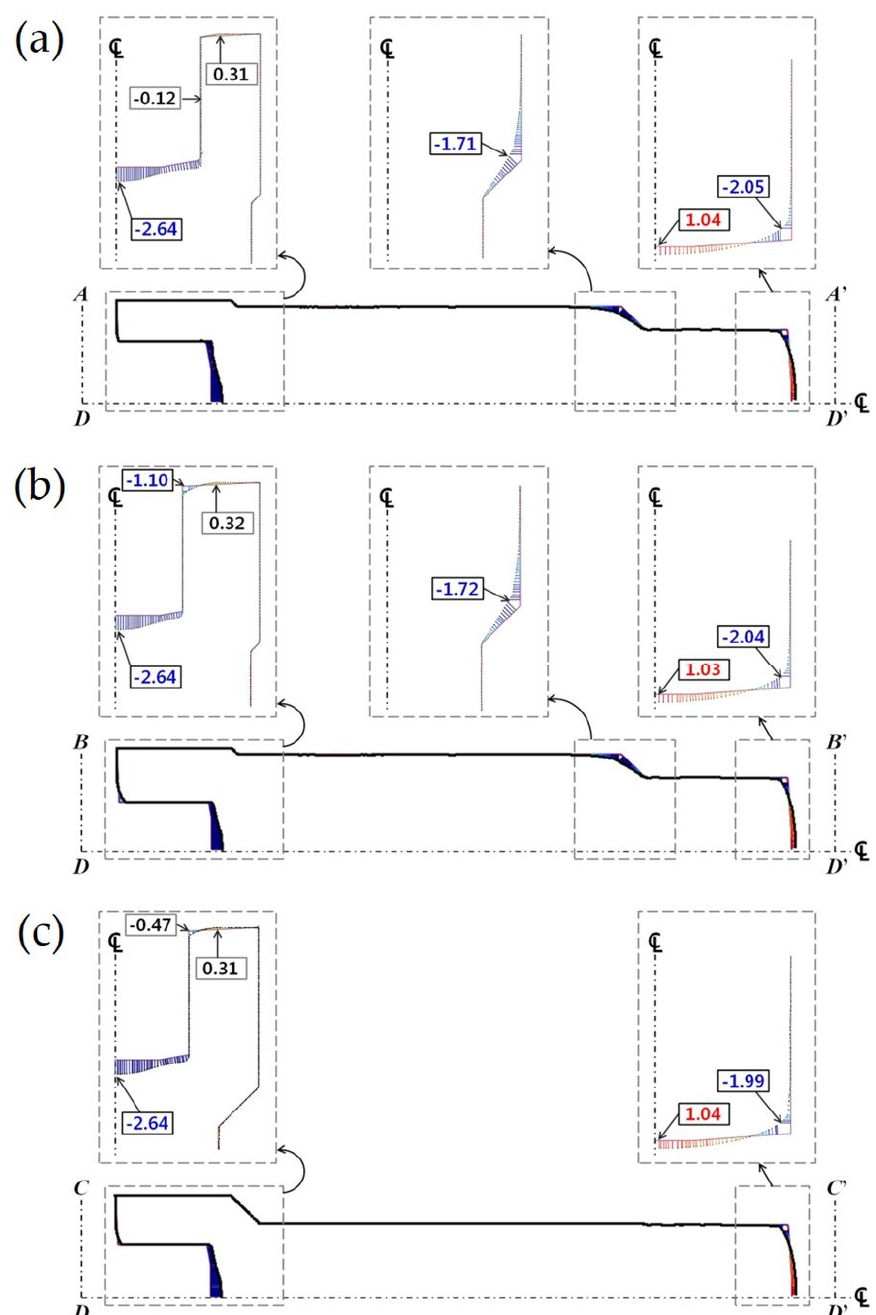
Figure 13. Dimensional variation between simulated layout and target shape of the drive shaft (unit: mm): ( a ) Shape comparison on DA - D ’ A ’ cross-sectional plane (top land direction); ( b ) Shape comparison on DB - D ’ B ’ cross-sectional plane (top land direction); ( c ) Shape comparison on DC - D ’ C ’ cross-sectional plane (bottom land direction).